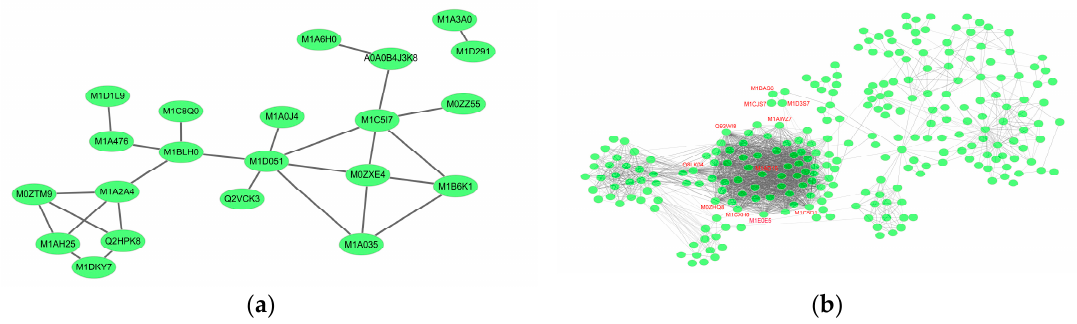
Figure 7. Network analysis results for significantly changed proteins in the ( a ) early and ( b ) late stages of infection.